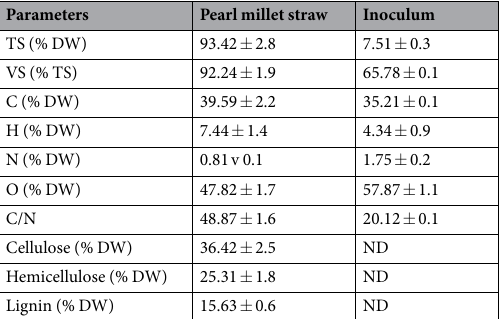
Table 2. Characteristics of pearl millet straw and inoculum. VS – Volatile solid; DW – dry weight; ND – not